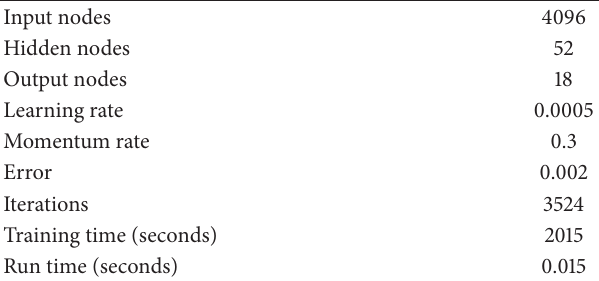
Table 3: Neural network final training